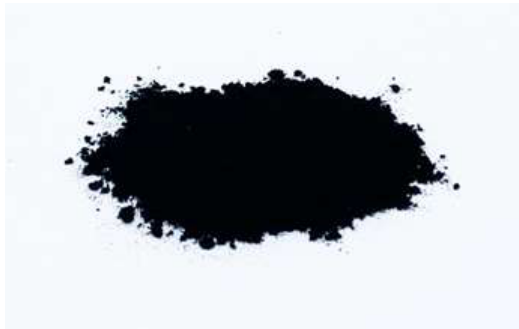
Fig. 1: Image of PPy nanoparticles powder